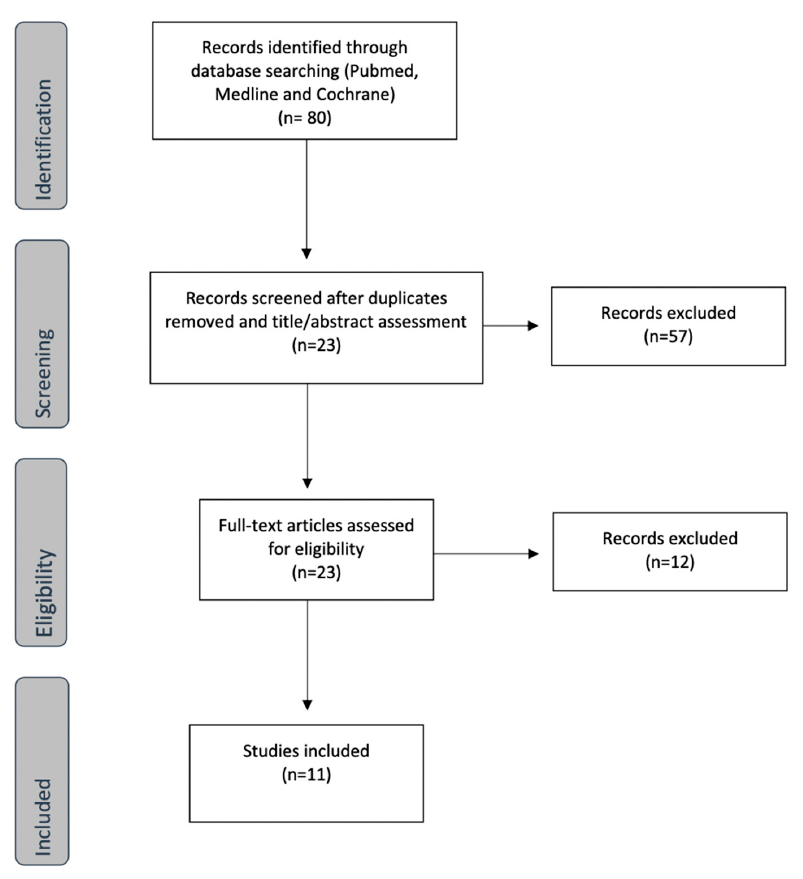
Figure 1. Flowchart of identified studies.